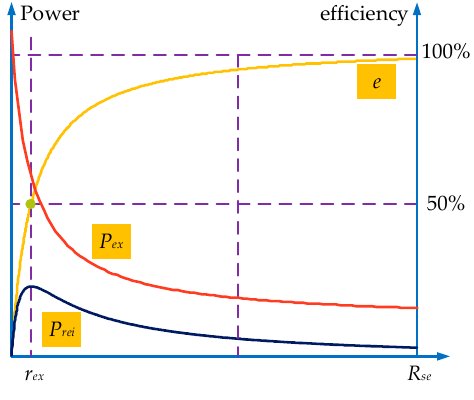
Figure 2. Relationship between R se , P ex , e and P rei .